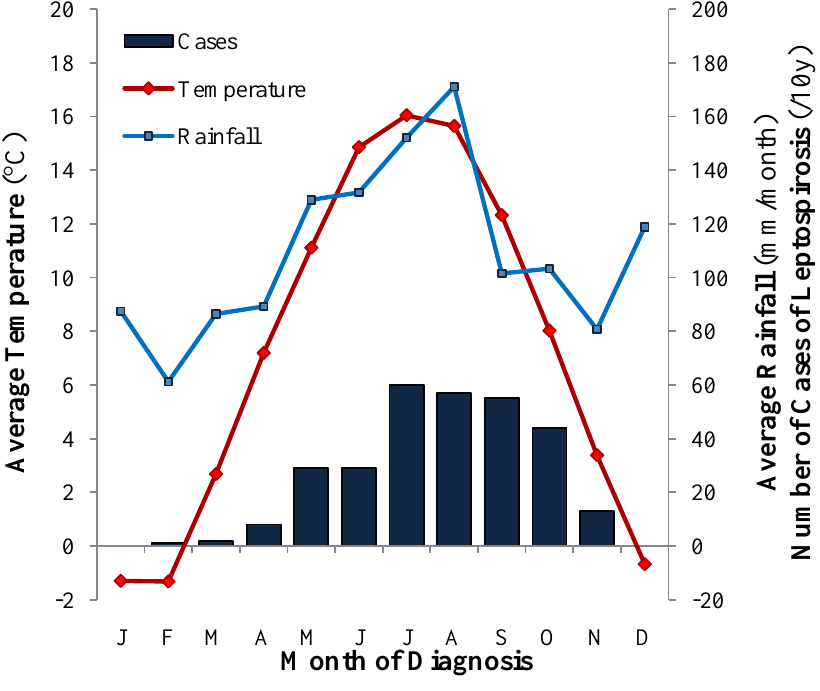
Figure 6. Seasonal distribution of 298 cases of canine leptospirosis in Switzerland and corresponding average monthly temperature and rainfall.